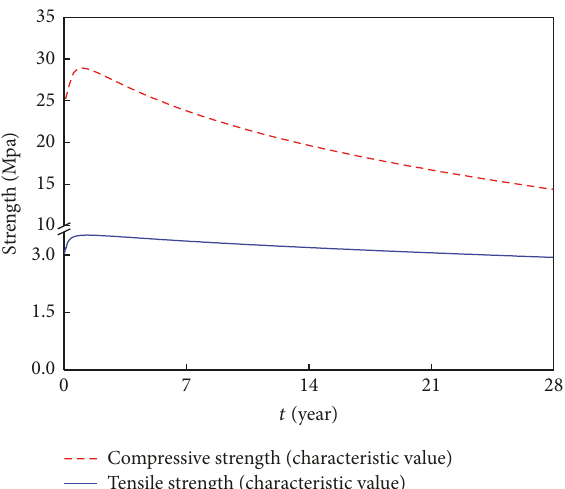
Figure 7: The subgroup shared by groups A, B, C, and D.